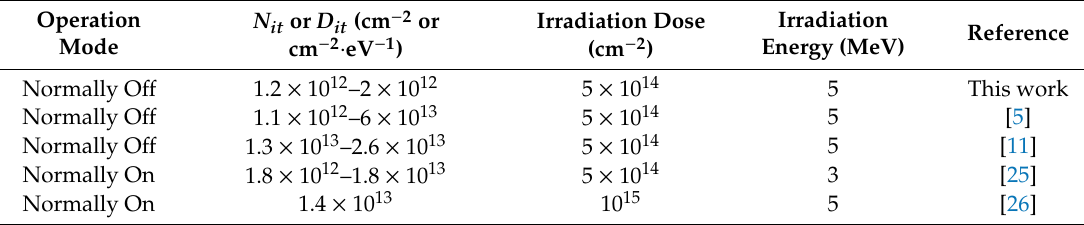
Figure 5. ∆ V th and N it drift over stress time up to 1000 s measured using a V GS of 8 V before and after proton irradiation. Table 1. The correlation between the interface traps states and the proton irradiation on GaN-based transistors.